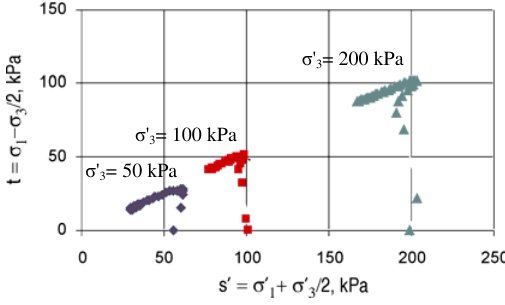
Fig 11 . Stress path of CU triaxial compression test